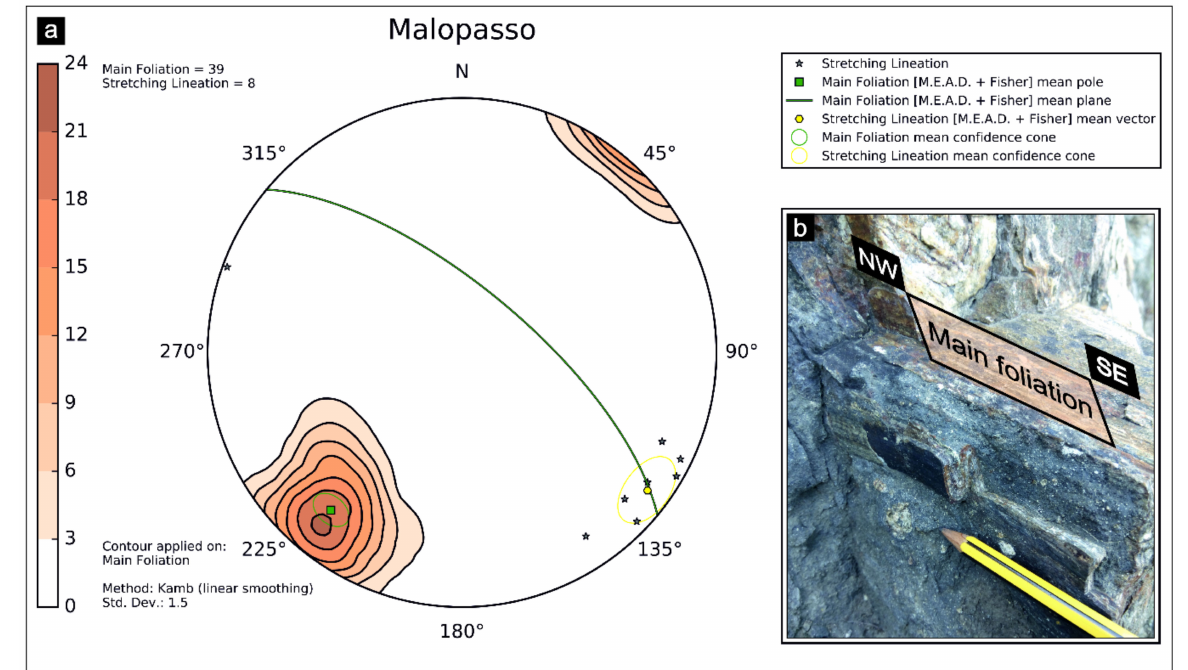
Figure 16. ‘Malopasso’ station: ( a ) equal-area azimuthal projection and statistical analysis of main foliations and stretching lineation data and ( b ) field example of tight isoclinal folds and smaller sheath folds developed in calc-silicates and skarns. The ASN log file is provided in Appendix B (Table